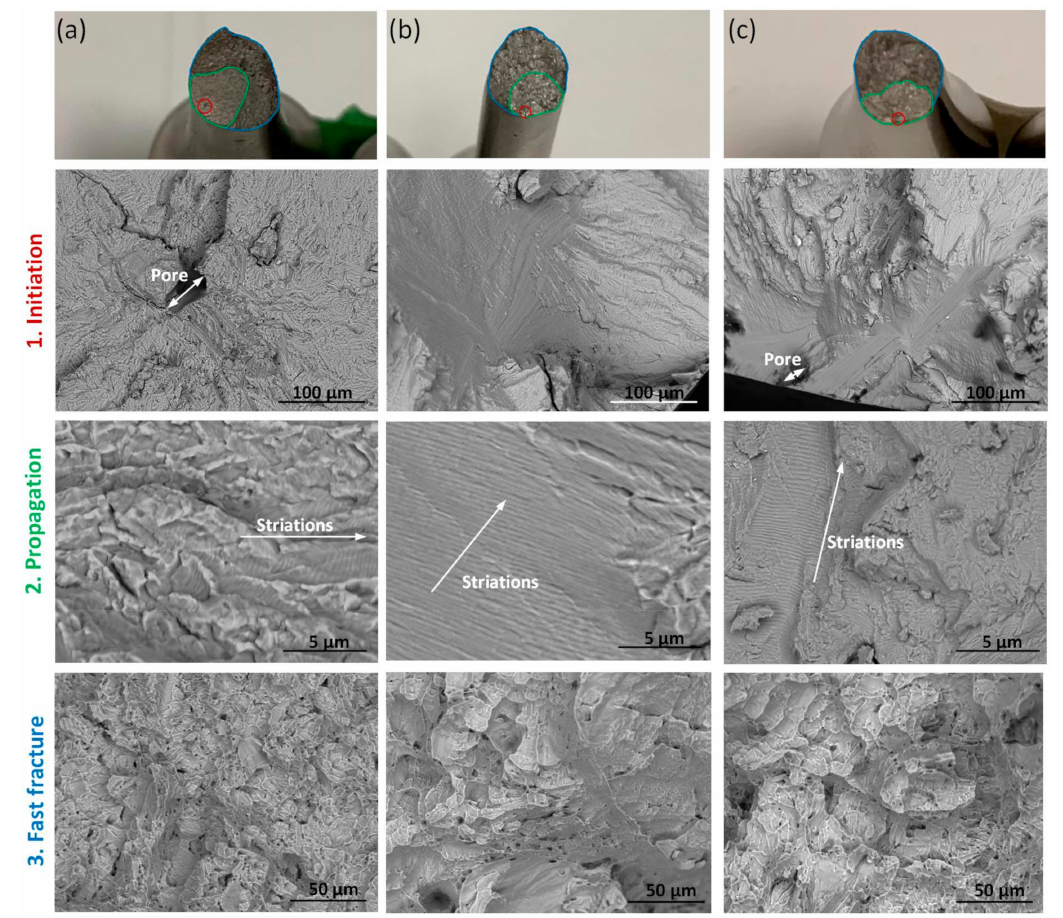
Figure 12. Fracture surface of the ( a ) PT1, ( b ) PT2, and ( c ) PT3 specimens. For the PT1 specimen, Zone 2 manifests poorly developed fatigue striations and shows secondary microcracks, which is not the case for the PT2 and PT3 specimens. The crack propagation stage occupies ~40, ~30, and 35% of the total fracture area for the PT1, PT2, and PT3 specimens, respectively, thus correlating with longer fatigue lives of the PT1 specimens as compared to their PT2 and PT3 counterparts, under the same maximum